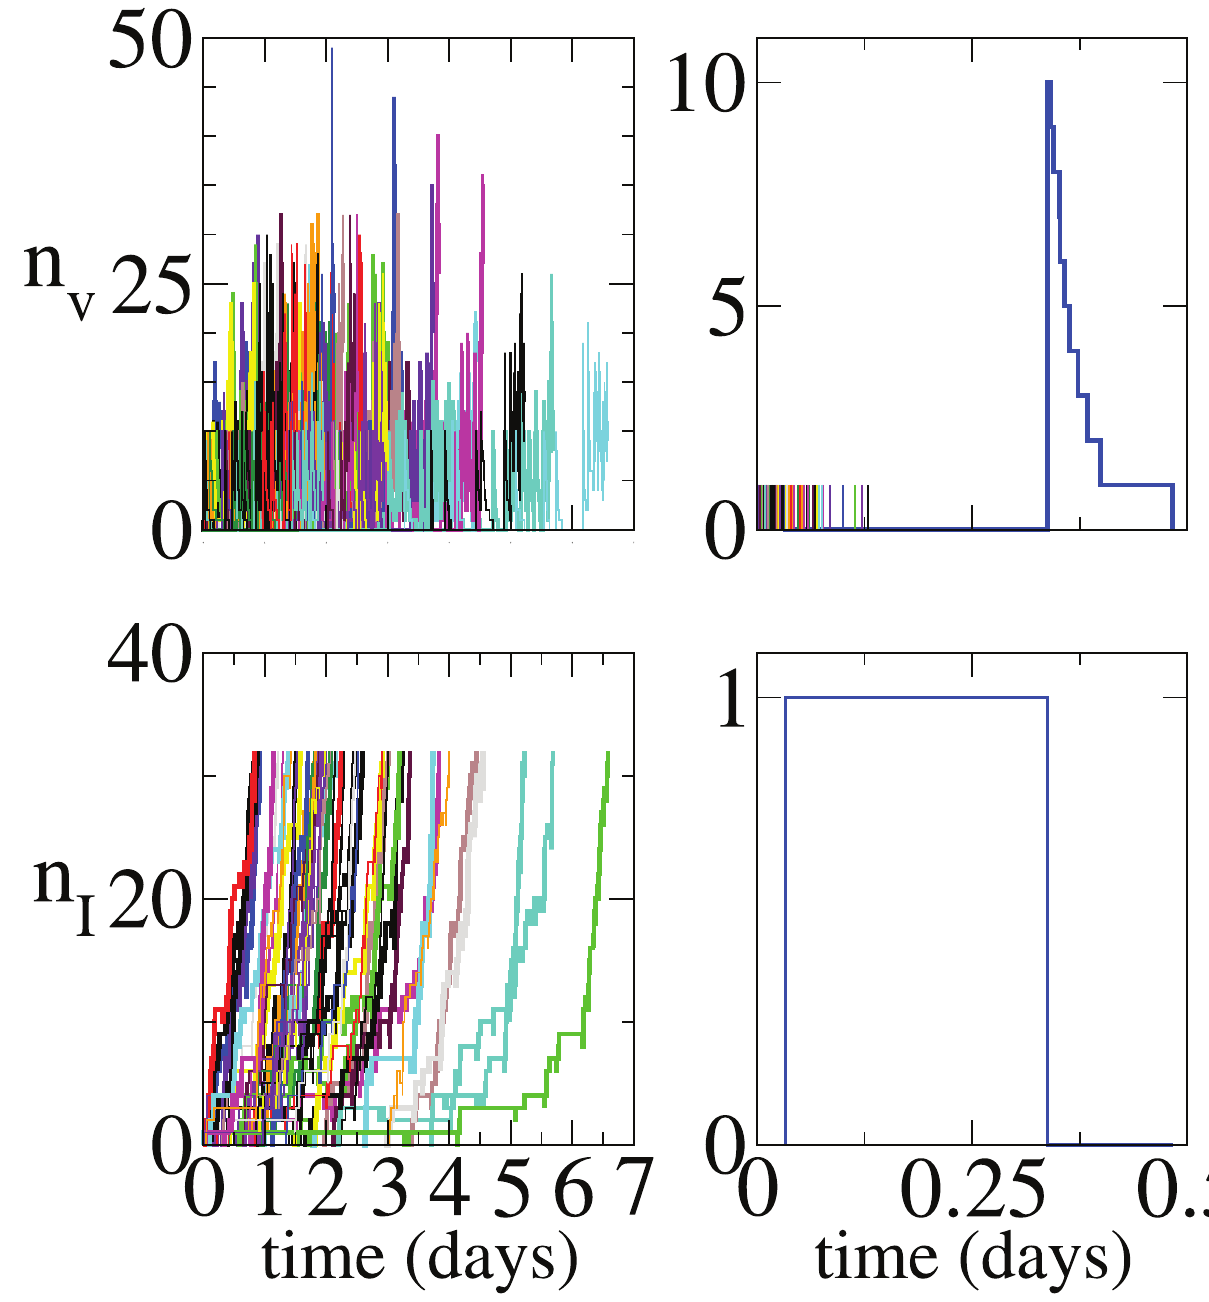
Figure 7. Burst model. Representative time series. Initial condition: n V ~ 1 , n I ~ 0 . Left column: 100 realizations that lead to infection. Right Column: 100 realizations that lead to